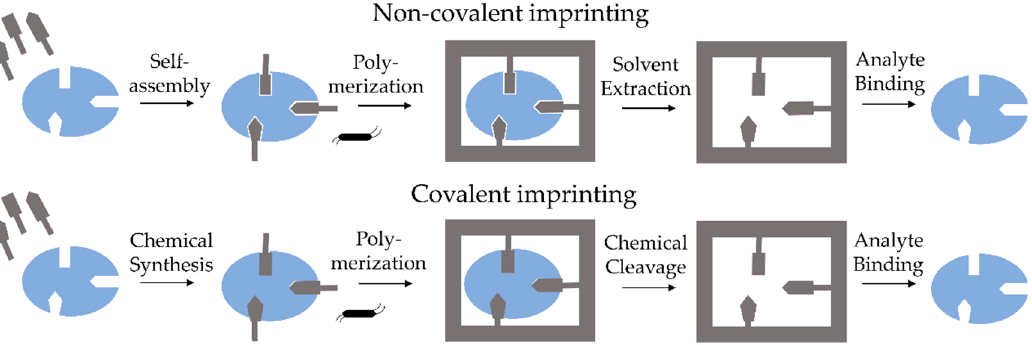
Figure 1. Schematic representation of covalent and non-covalent mechanisms of molecularly imprinted procedures.